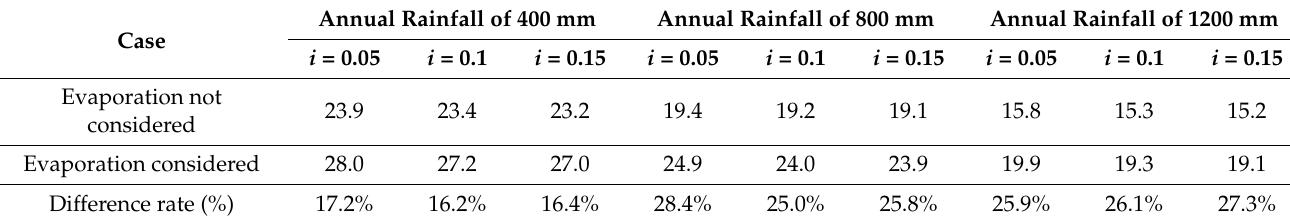
ble 5. Table 5. Minimum burial depth of the phreatic line